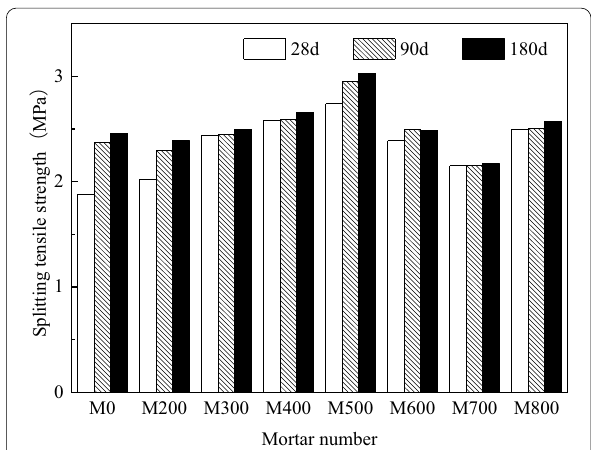
Fig. 10 Splitting tensile strength of attapulgite